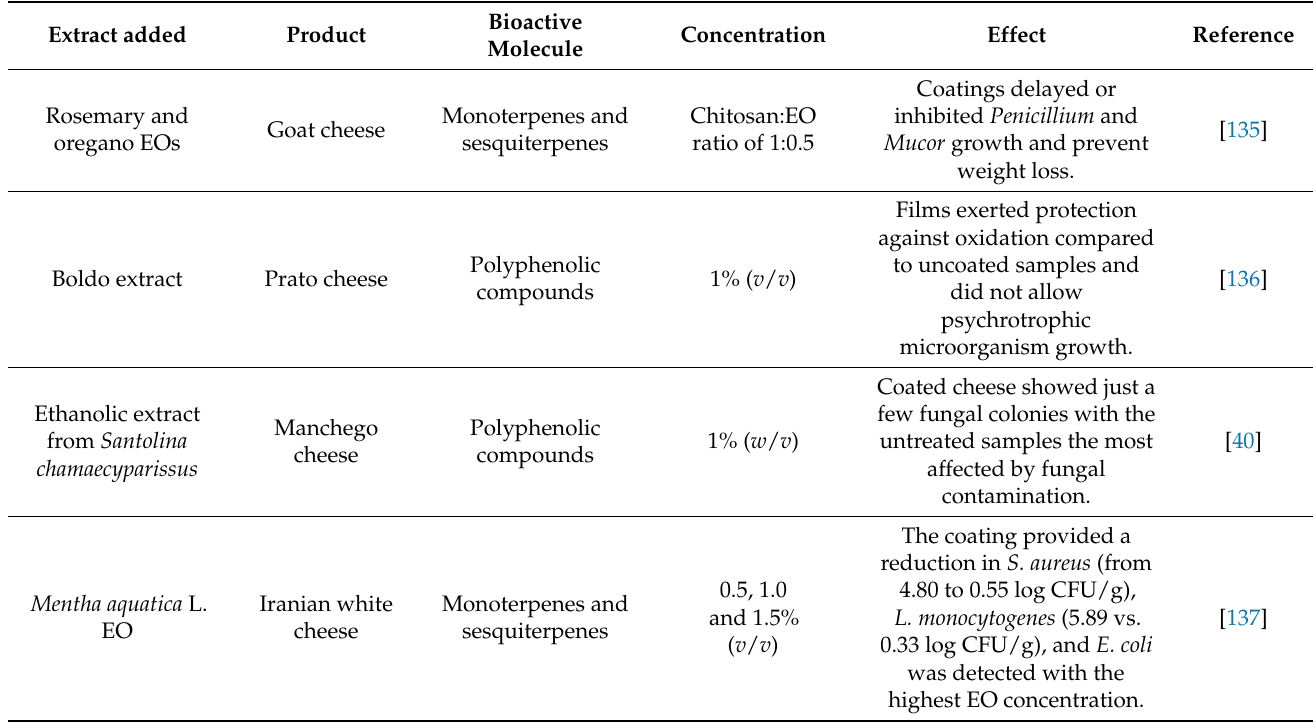
Table 5. Natural extracts incorporated in chitosan-based films and coatings for dairy